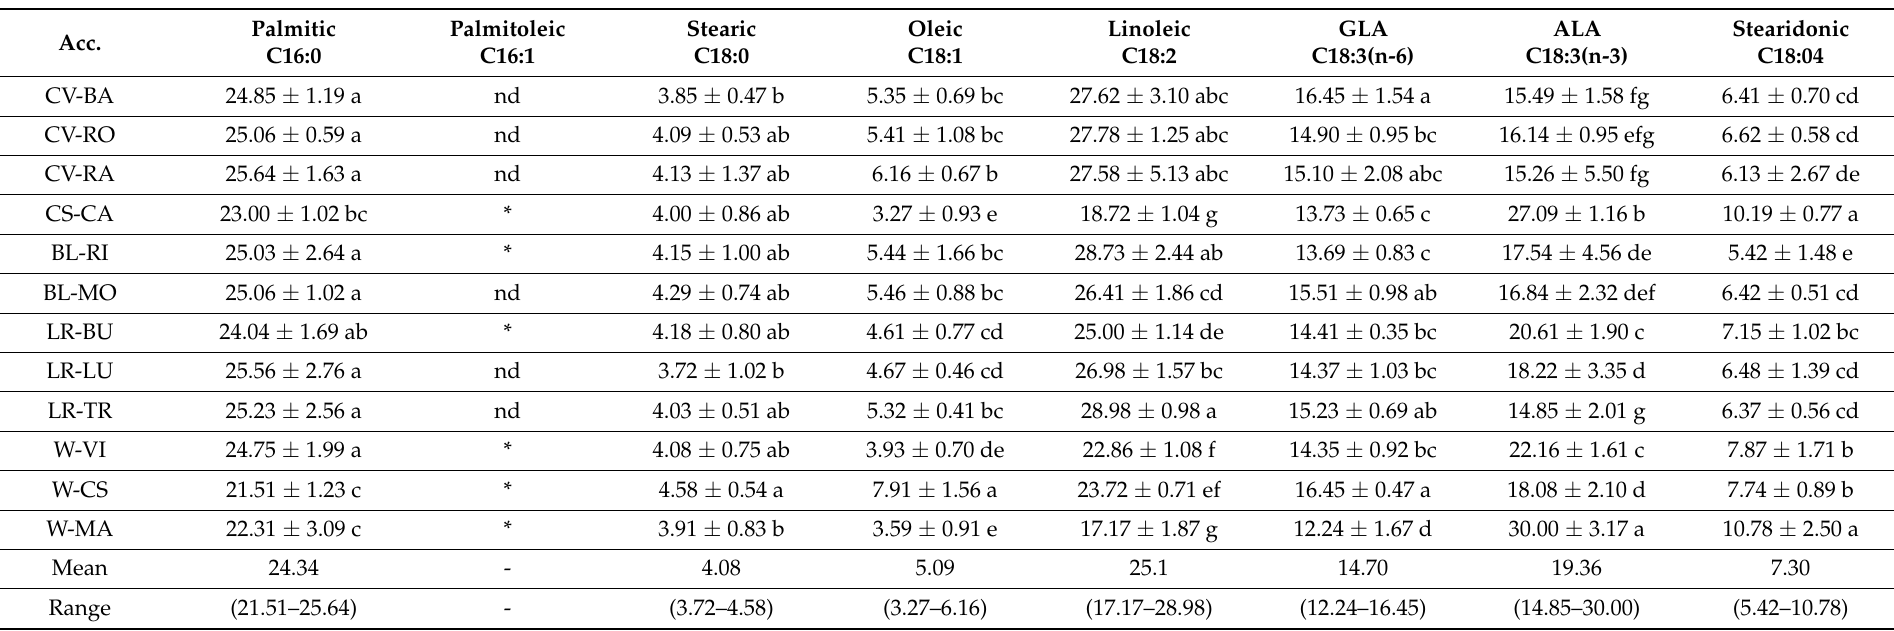
Table 2. Fatty acid composition, expressed in percentage of total fatty acids, of petioles of 12 borage accessions sampled at 120 days after sowing (Mean ± SD (n =